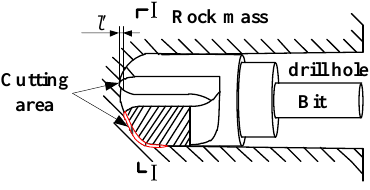
Figure 4. Schematic diagram of a bit invading rock.